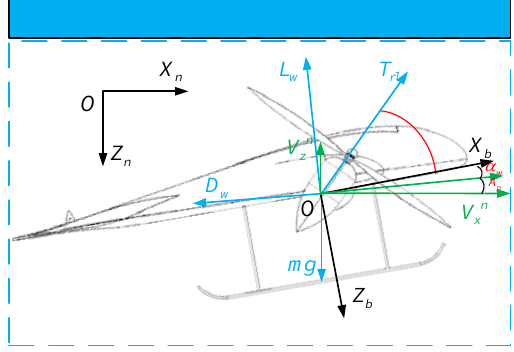
Figure 12. Forces analysis in TTO.